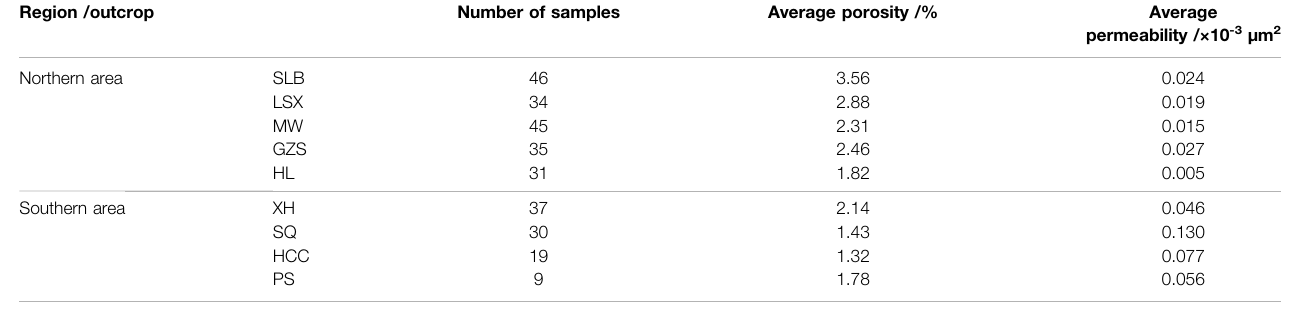
TABLE 1 | Average physical characteristics of the Xiaoheba formation of different areas in Southeast Sichuan. Region /outcrop